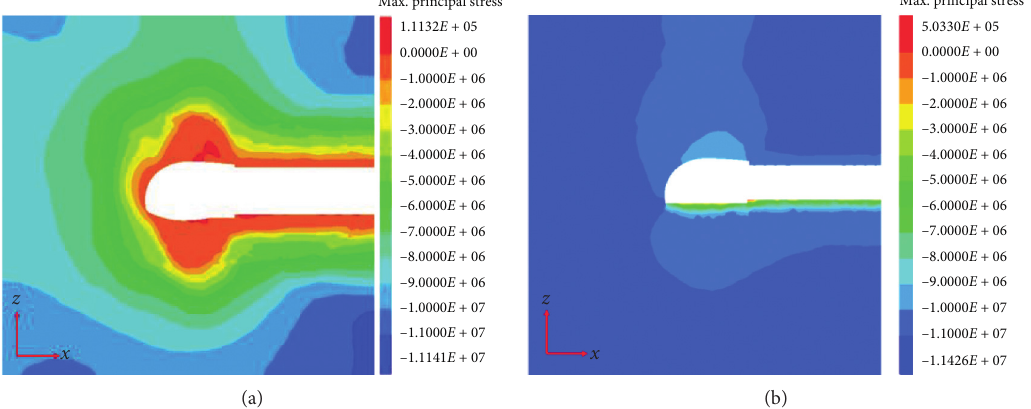
Figure 10: Maximum principal stress (slice plane 2). (a) Without support. (b) Prestressed anchor cable support.